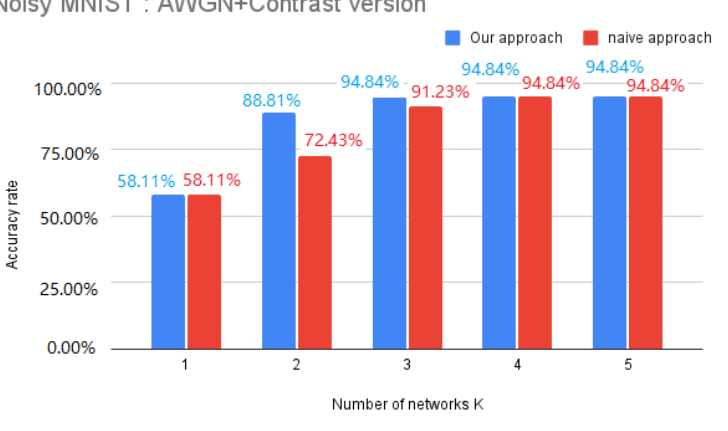
Figure 18. Classification’s accuracy on the MNIST dataset with reduced contrast + AWGN.